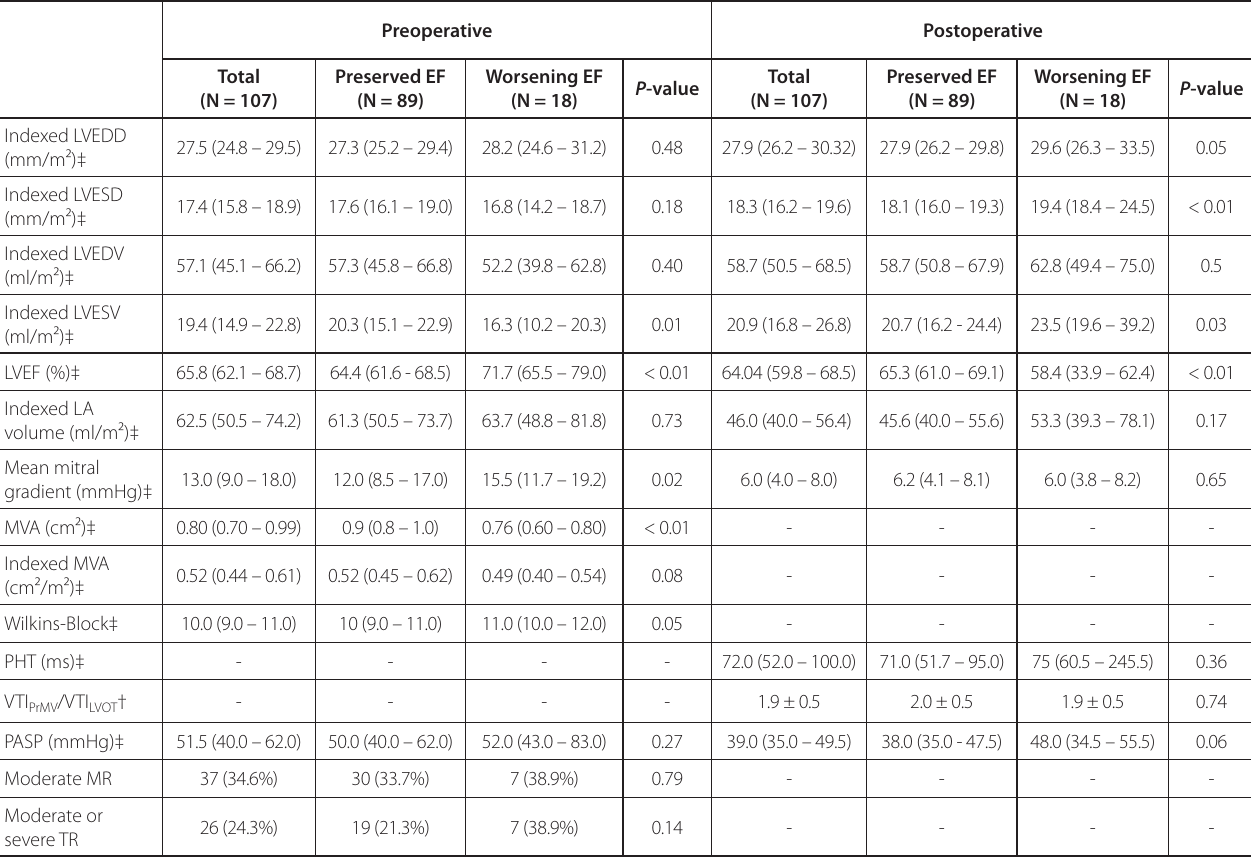
Table 3 . Distribution of echocardiographic data among study